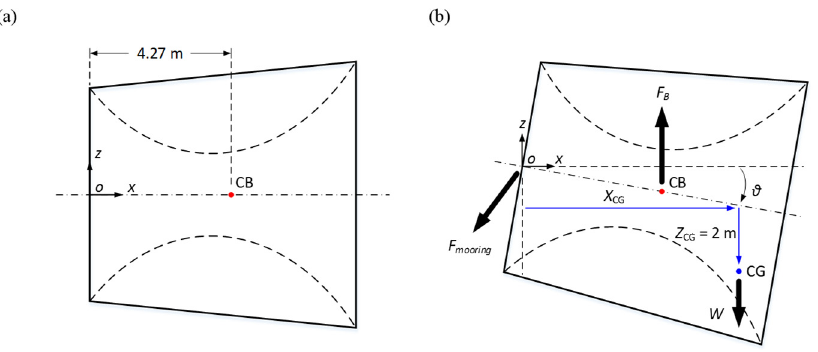
Figure 13. ( a ) CB position on the local coordinate system of the duct model; ( b ) force balance and the corresponding position of CG.